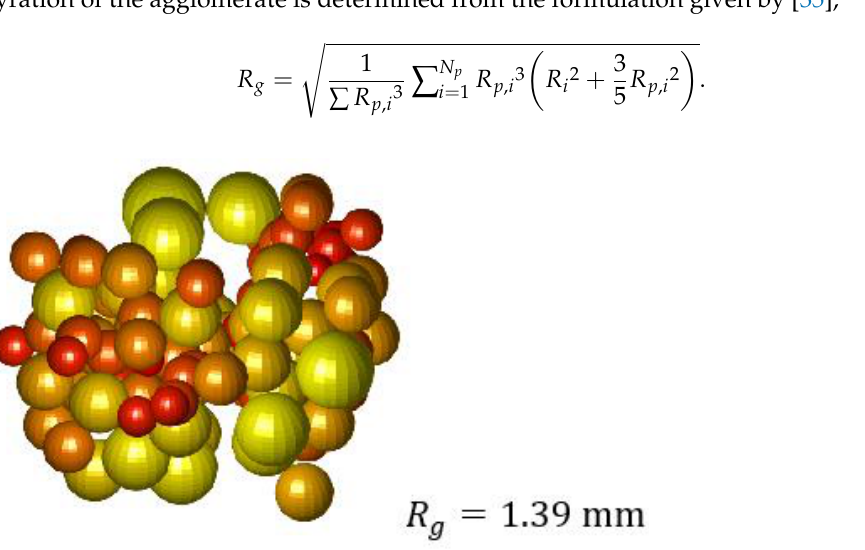
Figure 5. An exemplary agglomerate (with N p = 100; red for the smallest (122 µ m) and yellow for the largest (396 µ m) primary particle) generated using the MPTSA model (with R p = 260 µ m and σ = 52 µ 𝜎 = 52 µ m).